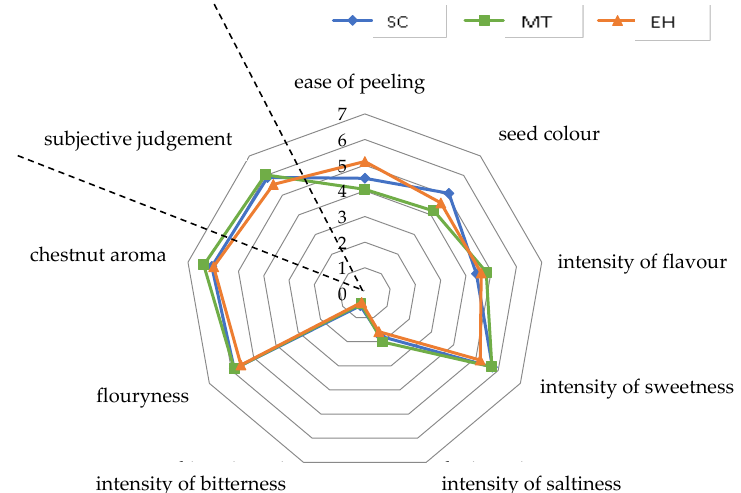
Figure 3. Radar chart for sensory analysis of considered chestnut groups (Sweet chestnut—SC, Marrone-type chestnut—MT, Euro-Japanese hybrid—EH). Subjective judgement is not part of radar chart for sensory analysis described by Quantitative Descriptive Analysis (QDA), but it was added together to other descriptors as complementary information.